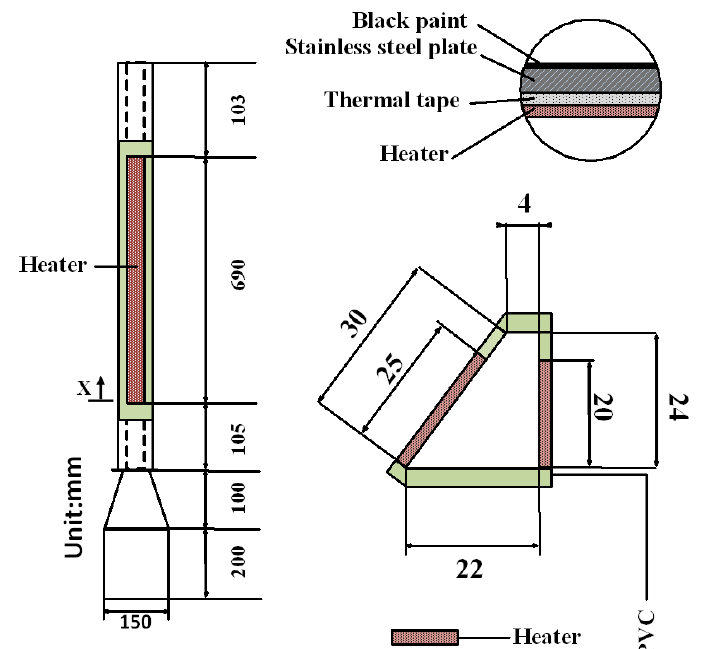
Figure 2. Drawing of the test section.